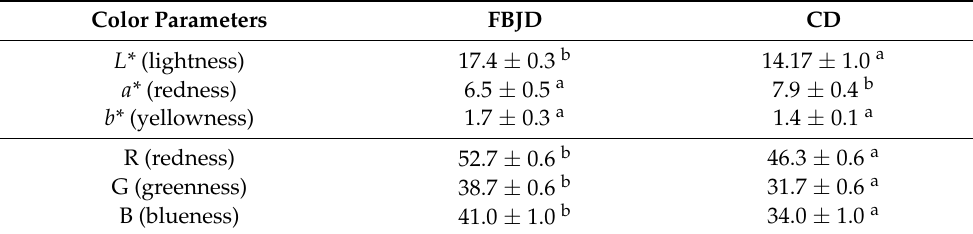
Table 5. Color parameters in CIE L*a*b* and RGB space obtained for chokeberry FBJD and CD powders using the instrumental method (‘electronic